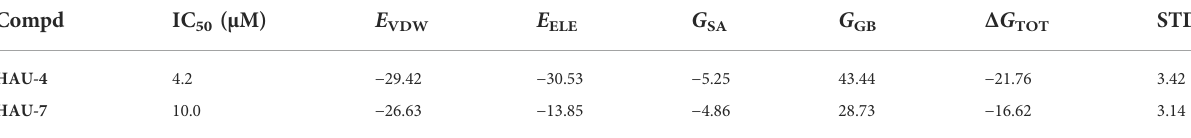
TABLE 2 Binding free energy of HAU-4 and HAU-7 calculated by MM/GBSA (kcal/mol). Compd